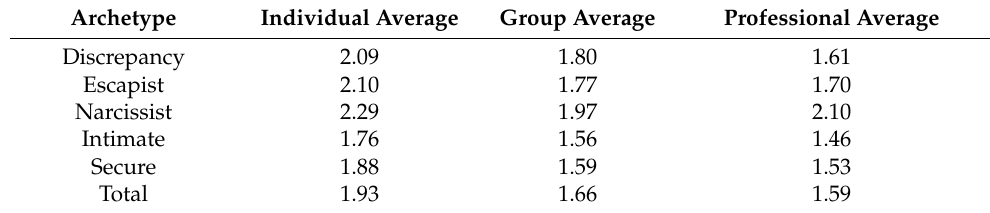
Table 13. Effects by